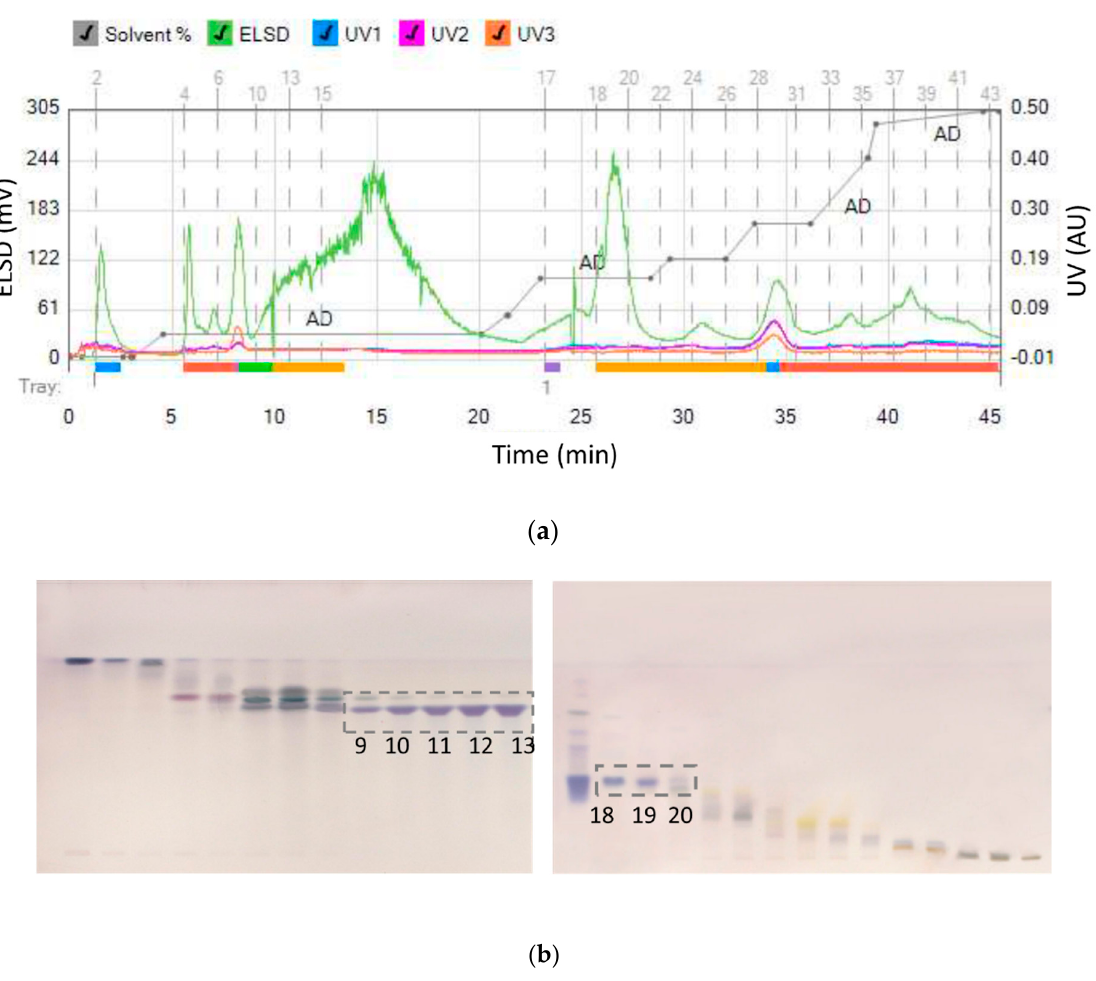
Figure 4. ( a ) Separation of ethyl acetate fraction from the water-ethyl acetate extract and ( b ) HPTLC assessment of collected fractions (9–13 oleanolic acid and 18–20 maslinic acid).